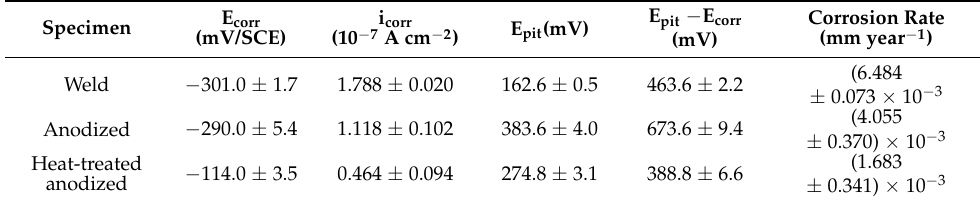
Table 2. Potentiodynamic polarization curve